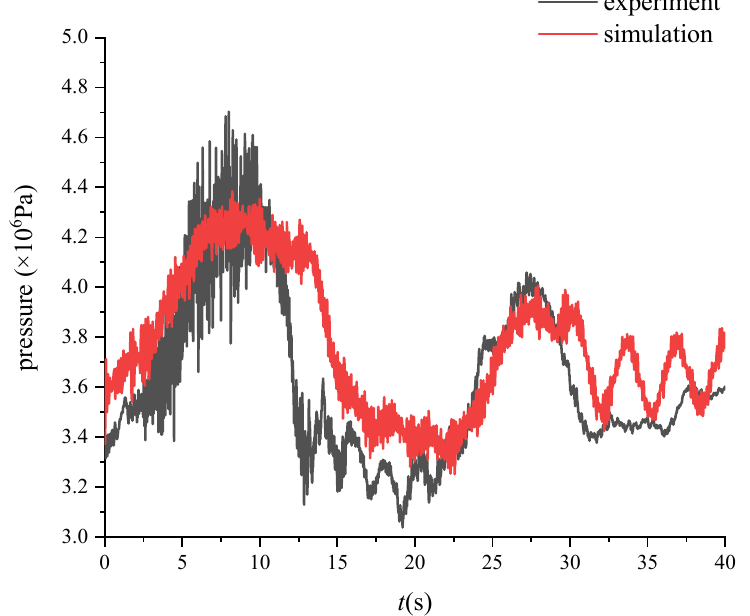
Figure 9. Comparison of the outlet pressure of the ball valve.